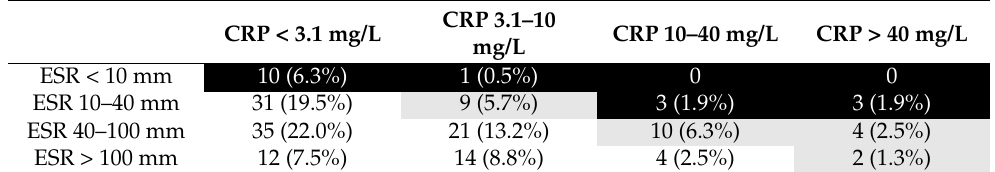
Table 4. Erythrocyte sedimentation rate and C-reactive protein crosstabulation matrix used for referral patients to the step 3 of the screening. Number and percentage of patients in studied population with both outcomes available were shown (N =